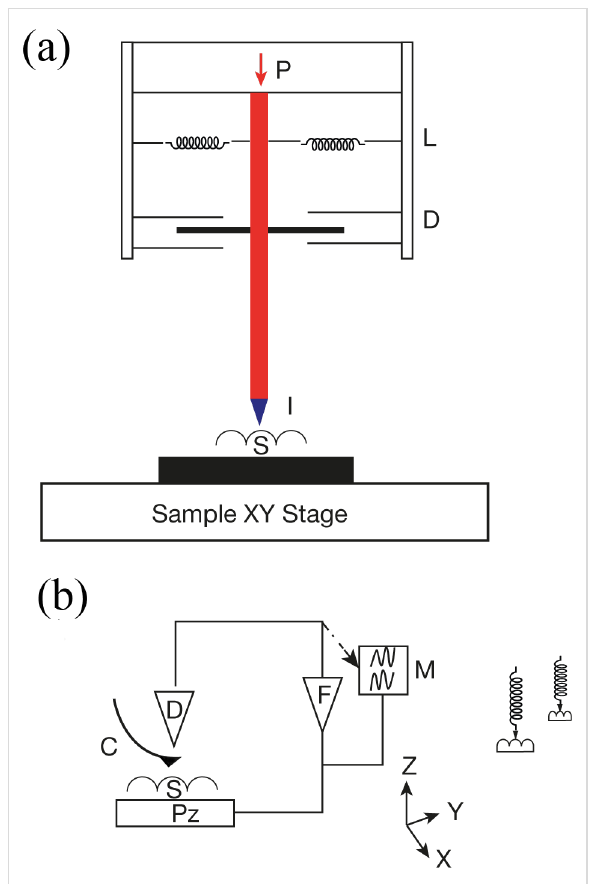
Figure 2: (a) Schematic of instrumented nanoindenter, including P - calibrated force; L - support springs; D - Position sensor; I - indenter tip supported by shaft; S - sample. (b) Schematic of AFM showing Pz - piezoelectric motion transducer; S -sample; C - integrated cantilever and tip; D - cantilever motion detector; F - feedback; M - monitor for display. To right the working of AFM is shown schematically: exten- sion of spring changes before and after applying load. From